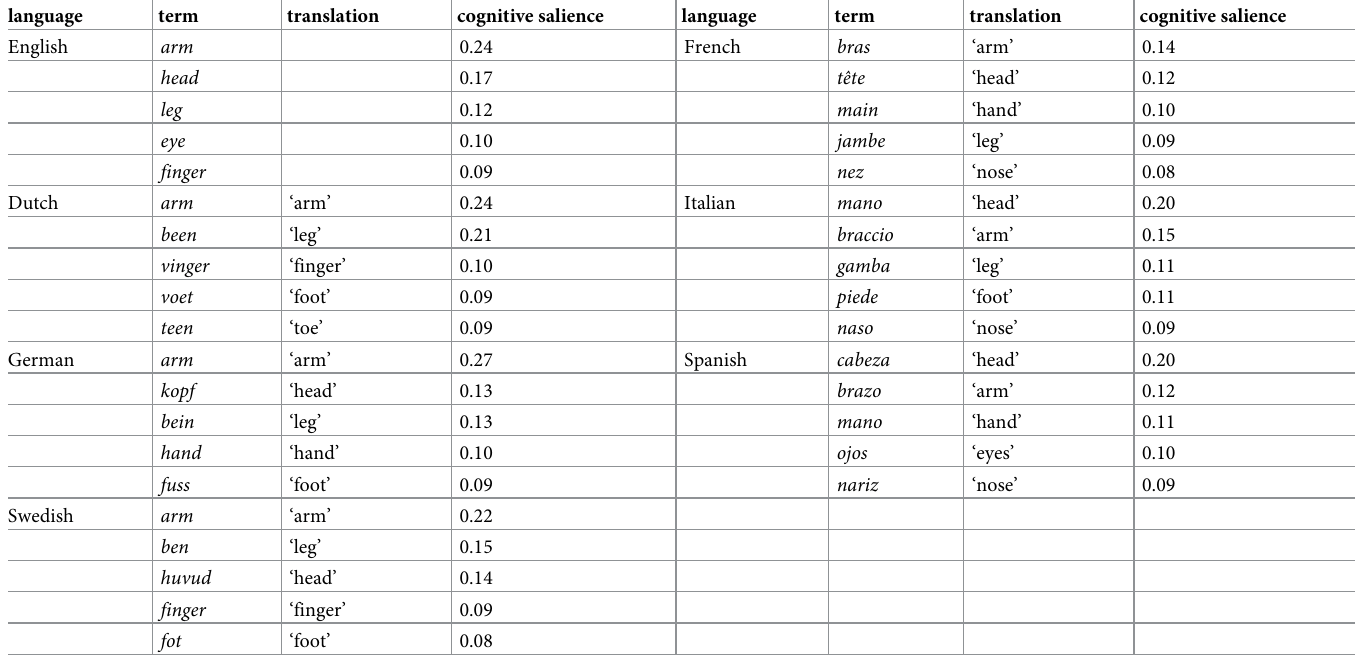
Table 4. The five most cognitively salient body part exemplars in each